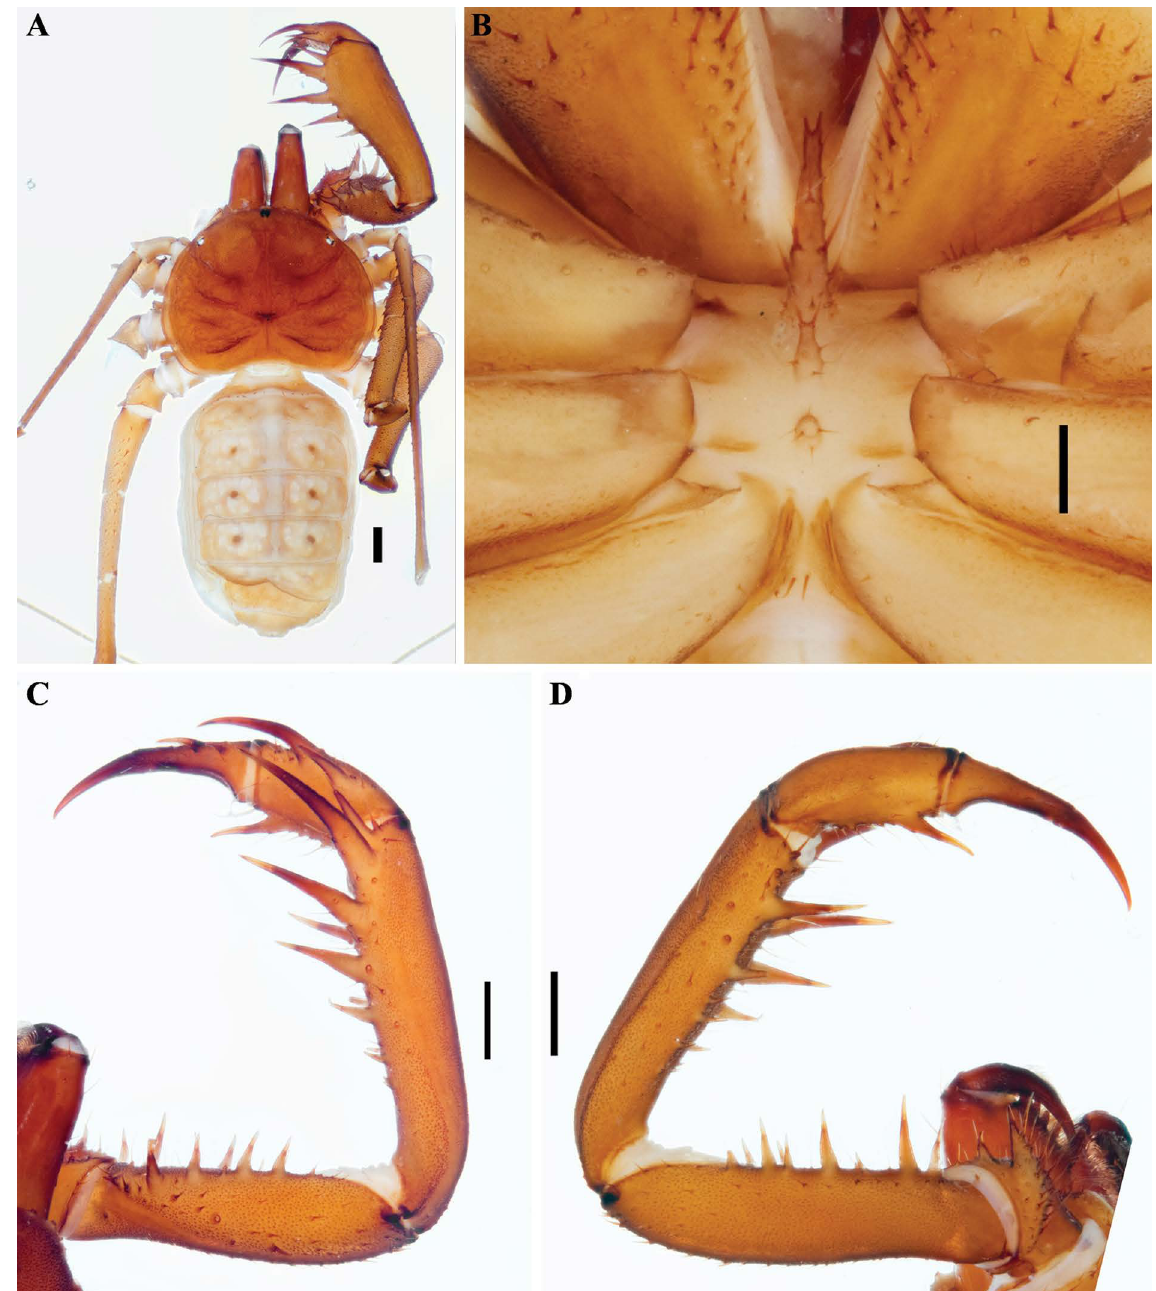
Fig. 104. Sarax batuensis Roewer (1962) (SMF), general morphology, ♀ . A . Habitus, dorsal view. B . Sternum, ventral view. C . Pedipalp, dorsal view. D . Pedipalp, ventral view. Scale bars: A, C–D = 1 mm; B = 0.5